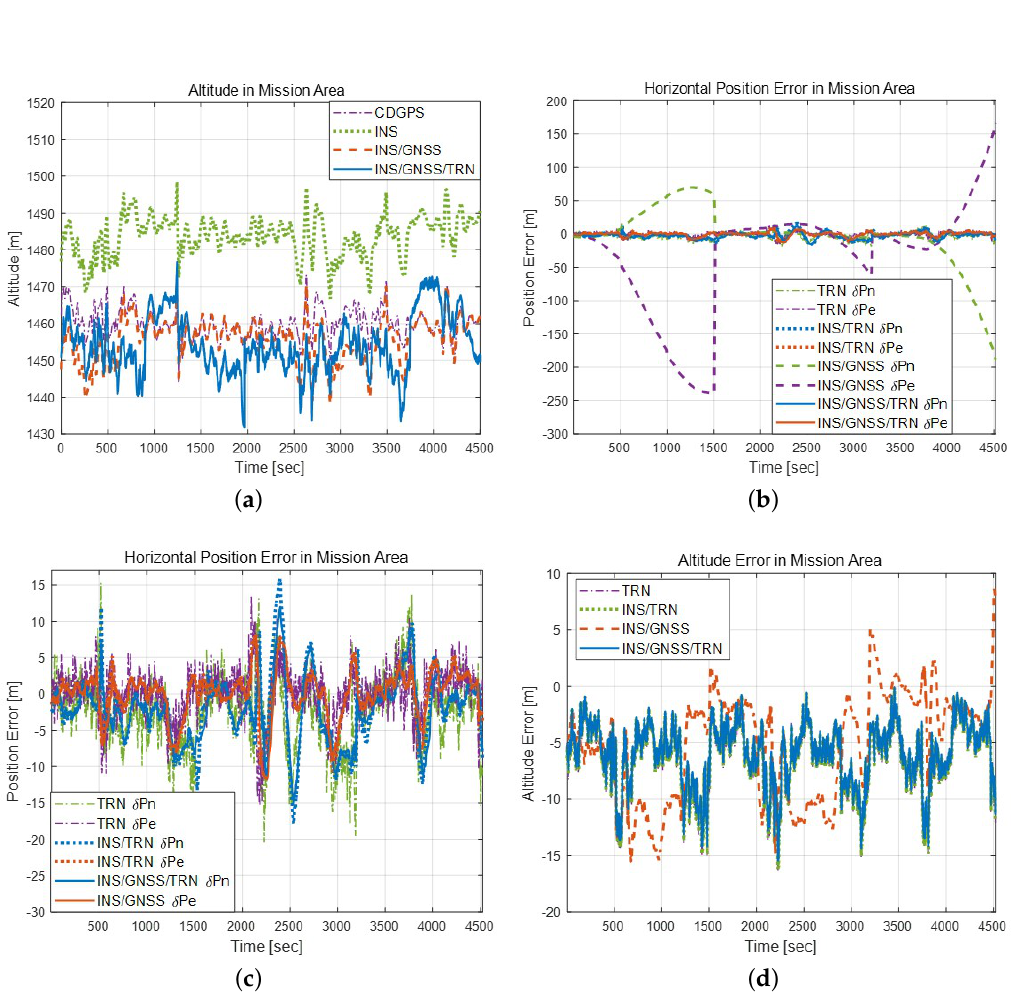
Figure 13. ResultsofCFT1 whenGNSSisunavailableinthemissionarea. ( a )Attitudeprofile. ( b )Horizontal position error. ( c ) Horizontal position error without INS/GNSS-aided navigation error. ( d ) Altitude